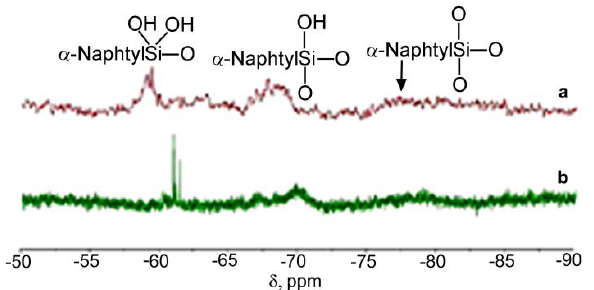
Figure 10. 29 Si NMR spectra of α -naphthyllsiloxane compounds from the reaction conducted for 48 h: